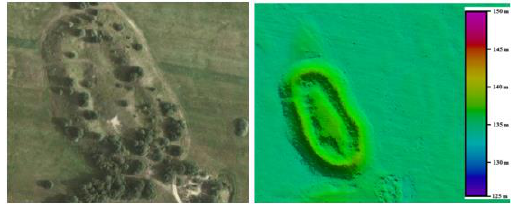
Figure 5. Classical aerial image and DTM – object